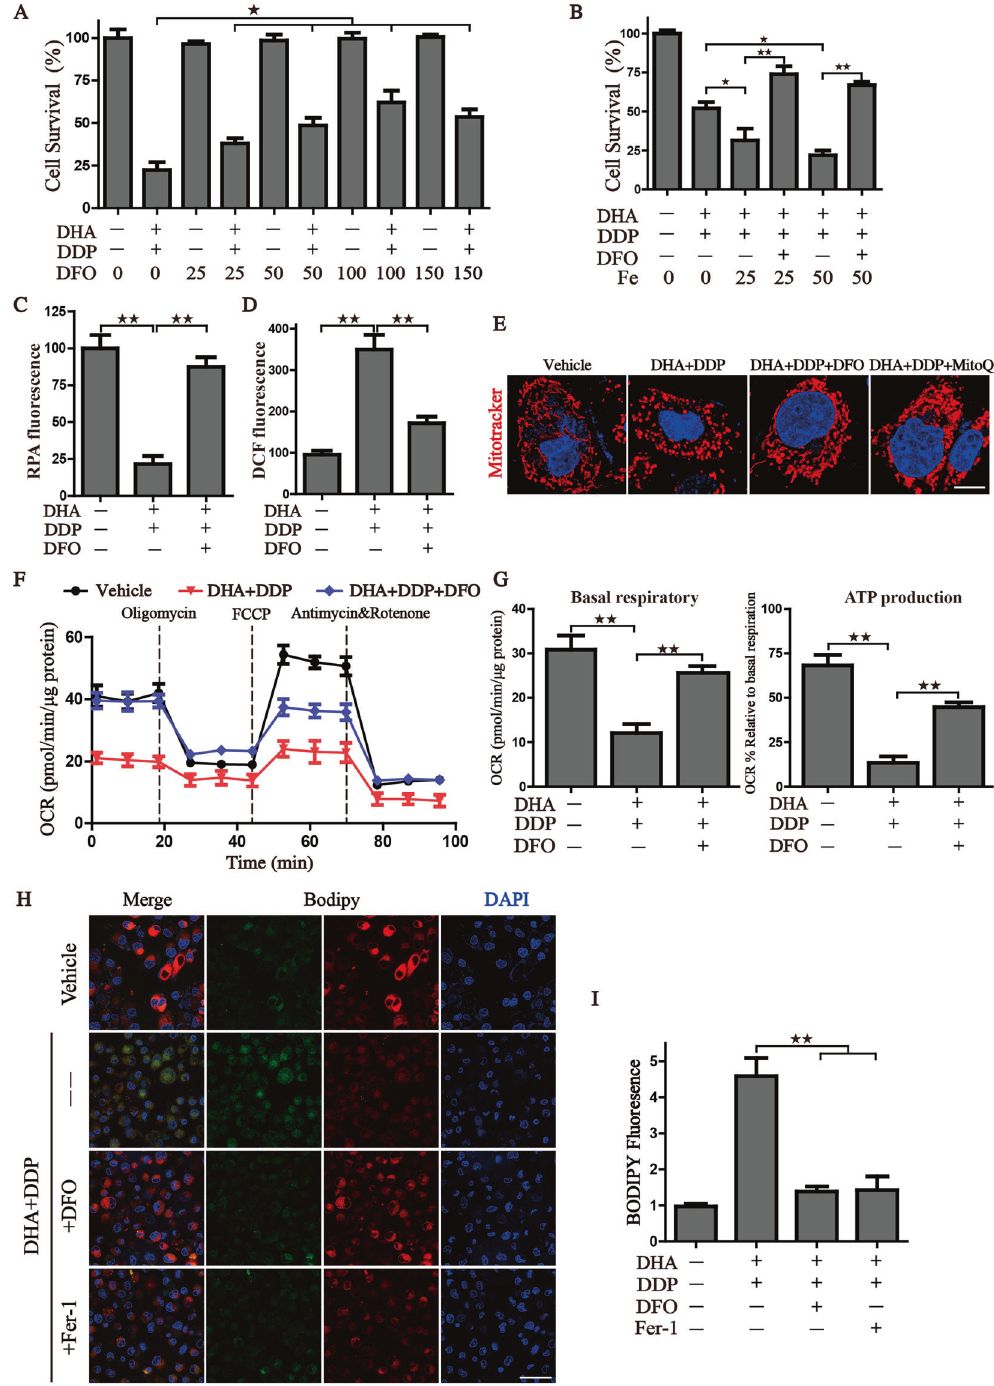
Fig. 6 Pharmacologic depleting of the free iron reservoir attenuates the DHA/DDP-induced ferroptosis. A PANC1 cells were treated with DHA/DDP (45 μ M) in the presence or absence of DFO. B PANC1 cells were treated with DHA/DDP (30 μ M) in the presence or absence of DFO and Fe 2 + , cell survival was detected by CCK8. C , D After indicated treatment, PANC1 cells were loaded with RPA or DCF-DA probe for 30 min, and fl uorescence intensities were detected by microplate spectrophotometer and normalized to the corresponding cell number. E MitoTracker Red labeled pancreatic cancer cells were subjected to the confocal microscope for observing the changes of mitochondrial morphology after the indicated treatment. Scale bars: 10 μ m. F , G OCR of PANC1 cells was carried out with a Seahorse analyzer after the addition of oligomycin, FCCP, and Antimycin A/Rotenone. The basal respiration and ATP production were calculated on the right. H , I To assess lipid ROS production, pancreatic cancer cells were treated with DHA and DDP with or without DFO, fer-1. Treated cells were loaded with BODIPY C11 probe for 30 min followed by confocal laser microscope. Scale bars: 50 μ m. Statistical results of the fl uorescence intensities were shown on the right (values represented mean ± SD. ★ P < 0.05, ★★ P < 0.01 versus control).